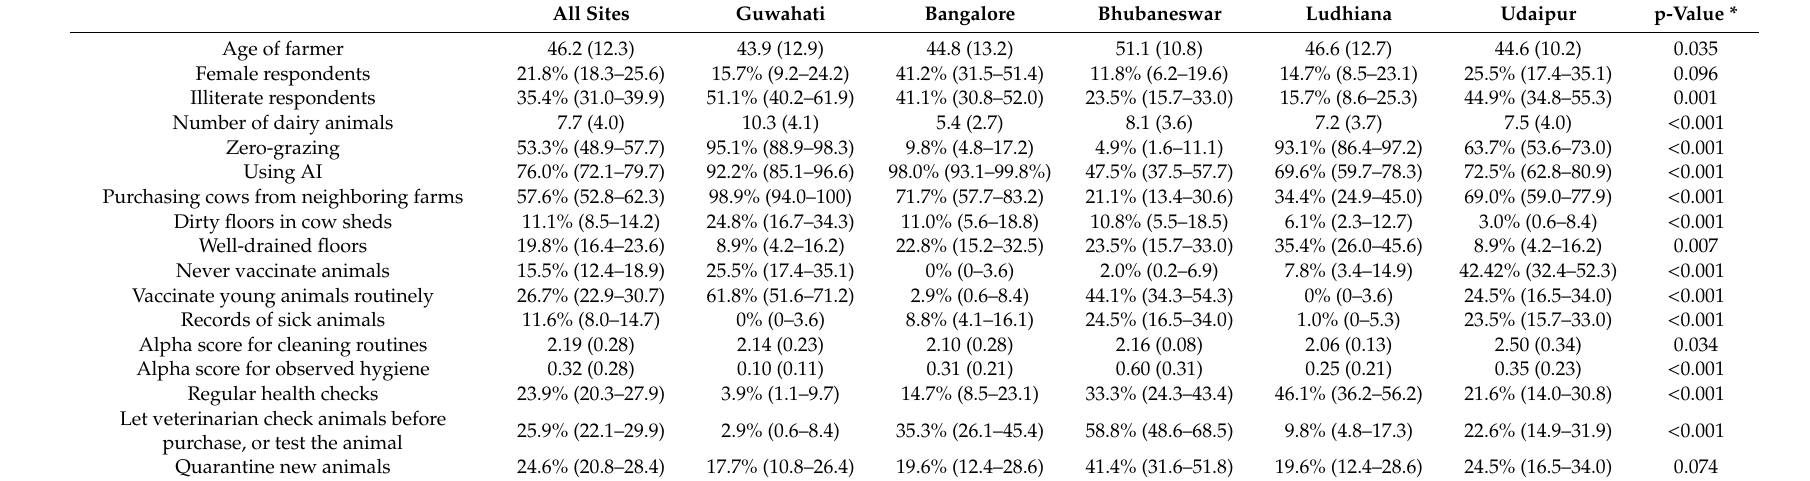
Table 1. Potential risk factors for brucellosis given as either mean (standard deviation), or proportion (95% confidence interval). All